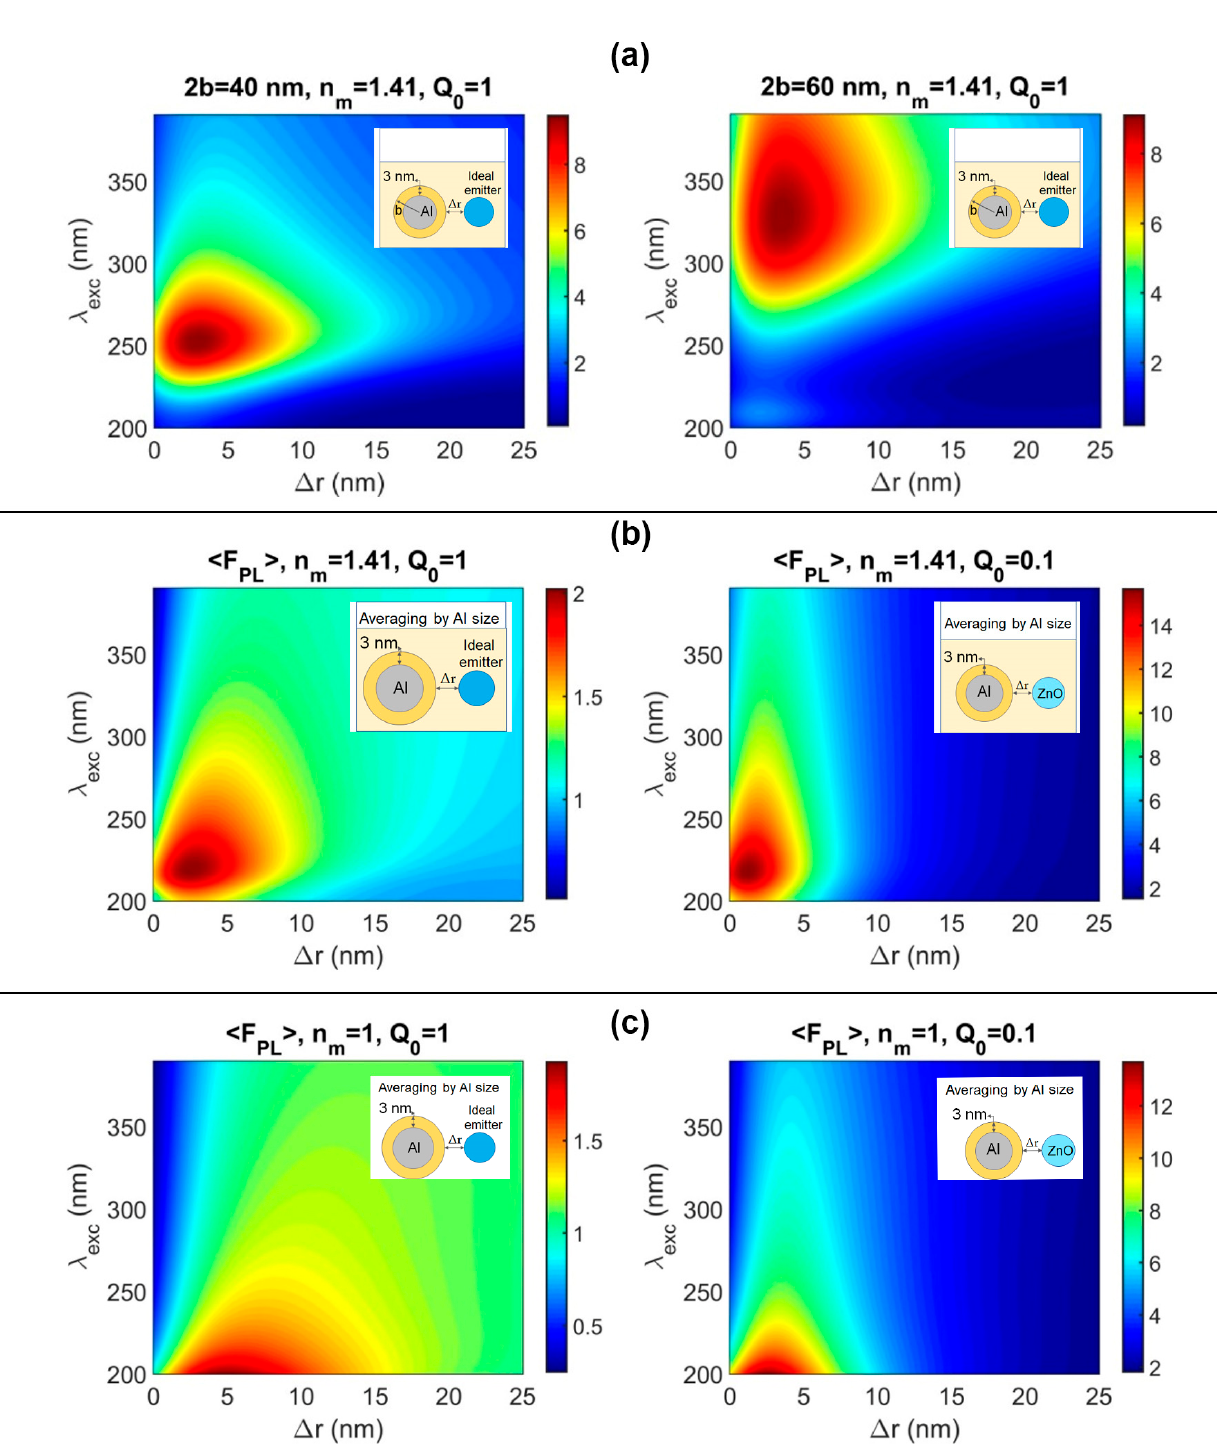
Figure 5. Calculated photoluminescence intensity enhancement factor versus excitation wavelength and metal–emitter spacing for emission wavelength 390 nm for Al nanospheres ( a ) 40 and 60 nm in diameter in isopropanol, intrinsic quantum yield Q 0 = 1; ( b ) enhancement factor of PL in isopropanol (n = 1.41) averaged over the size of metal nanoparticles and the direction of the electric component of the exciting radiation to the dipole moment of the fluorophore; ( c ) enhancement factor of PL in air atmosphere (n = 1) averaged over the size of metal nanoparticles and the direction of the electric component of the exciting radiation to the dipole moment of the fluorophore with different quantum yields (Q 0 = 1 and Q 0 =